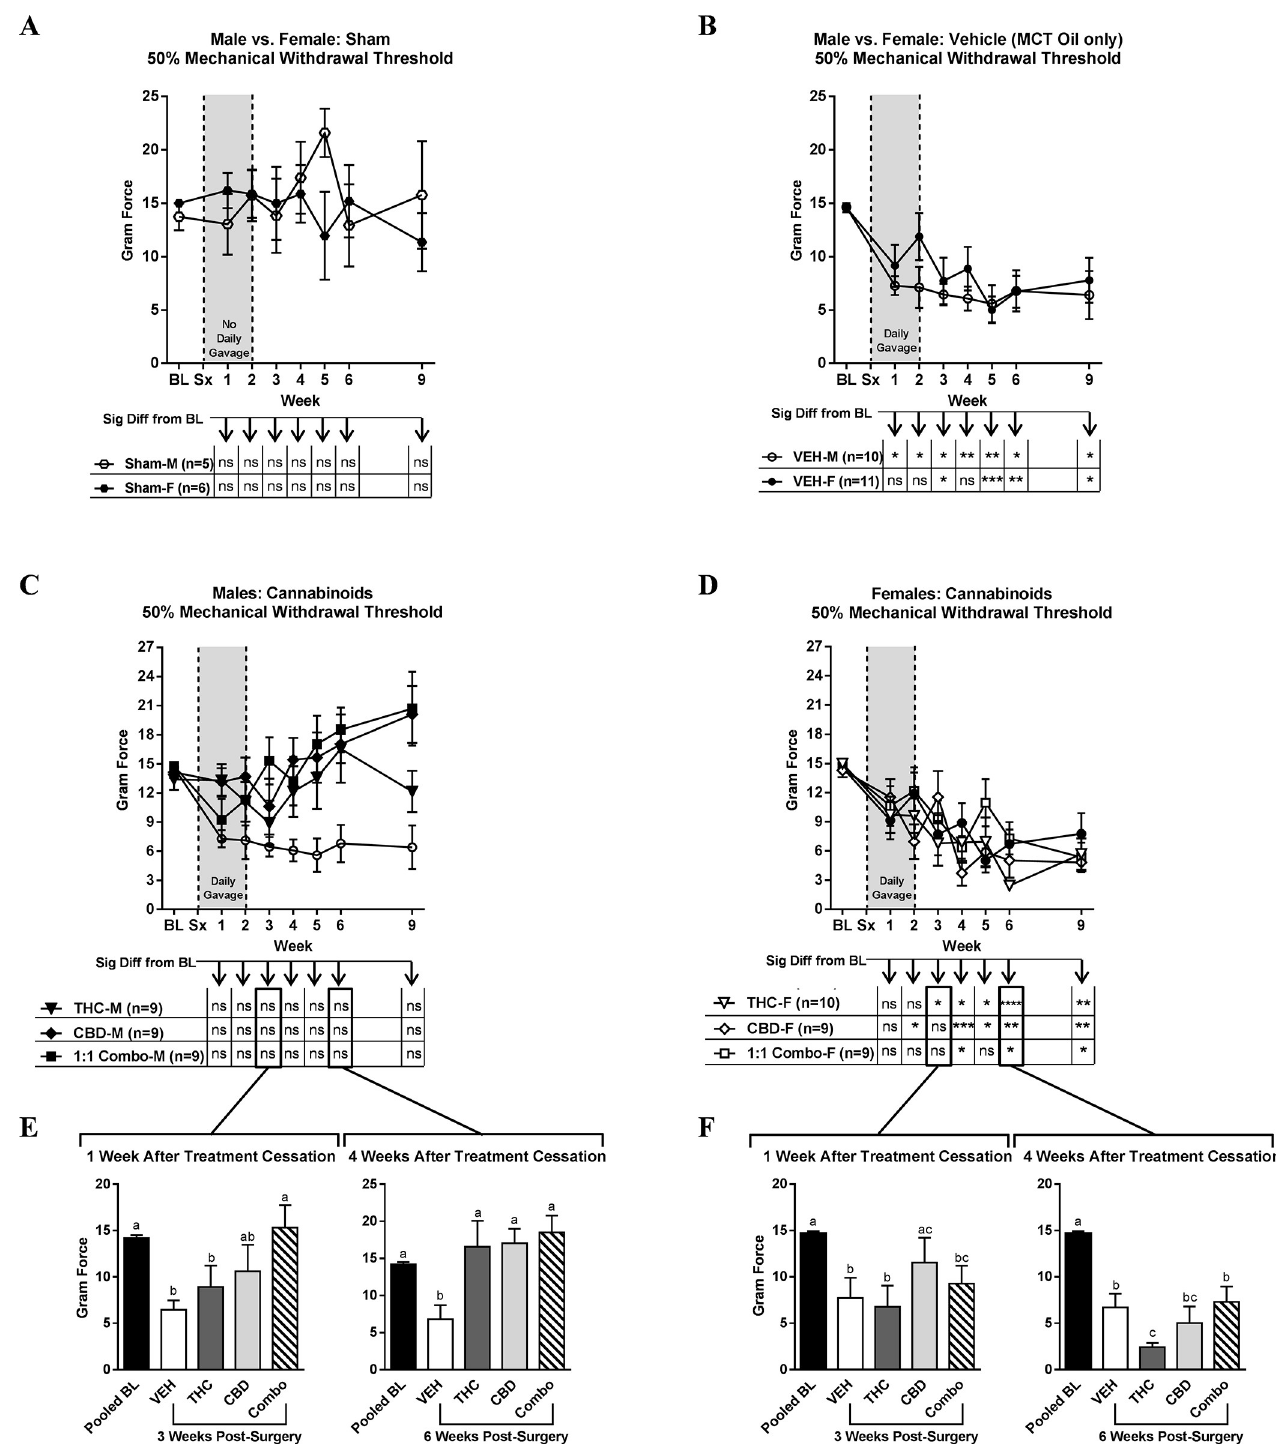
Fig 1. Mechanical withdrawal thresholds for behavioural comparisons of sham, vehicle-treated, and cannabinoid-treated males and females. Withdrawal thresholds plotted over a 9-week time course, with baseline (BL) and surgical intervention (Sx) indicated in A) male and female sham rats that underwent surgery without implantation of a sciatic nerve cuff; B) sciatic nerve cuff-implanted male and female rats treated with MCT oil alone (vehicle; VEH); C) sciatic nerve-cuff implanted male rats treated with THC, CBD, or a 1:1 combination of THC:CBD (Combo) for 2 weeks compared to VEH; D) sciatic nerve-cuff implanted female rats treated with THC, CBD, or a 1:1 Combo for 2 weeks compared to VEH. Data in E) and F) reflect time points corresponding to 1 week and 1 month after treatments had ceased (3 and 6 weeks post-nerve cuff implantation in C) and D) , respectively). All data is expressed as the mean gram